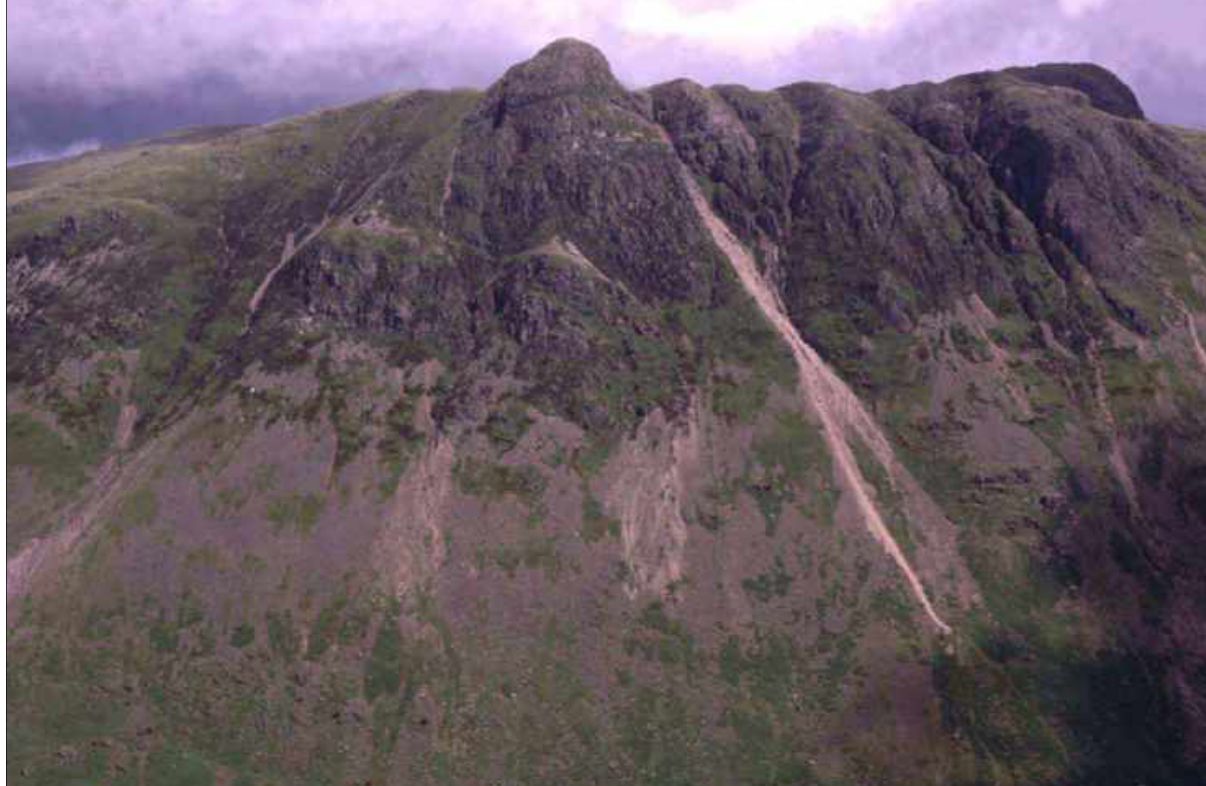
Fig 2.23 Pike O Stickle in Langdale, Cumbria, site of Neolithic axe production (OA